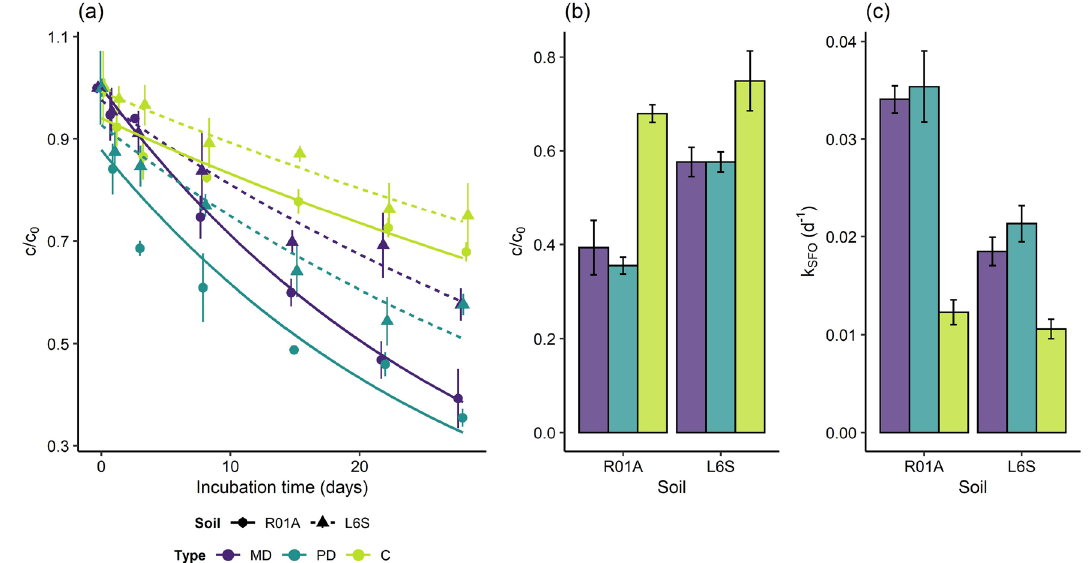
Figure 1. AFB1 dissipation for the sandy loam soil “R01A” (solid lines + points) and clay soil “L6S” (dashed − 1 lines + triangles) both fortified with 50 µ gkg AFB1 and subjected to microbial degradation “MD” (purple), photodegradation “PD” (dark cyan) and the sterile control in darkness “C” (light green). Curves showing single first order kinetic model fitted to data ( a ), normalized AFB1 concentration c/c 0 at the end of 28-days incubation ( b ) and single first order dissipation rate constants ( c ). Results are presented as mean ± standard deviation